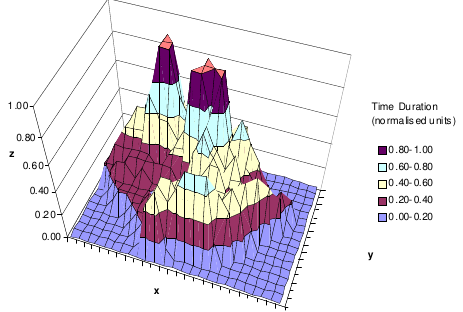
Figure 6(a). Flat plane representation of sampled data in the form of a contour plot of normalised time duration for the gathering sites of cows. Bright orange areas represent gathering points for urination.